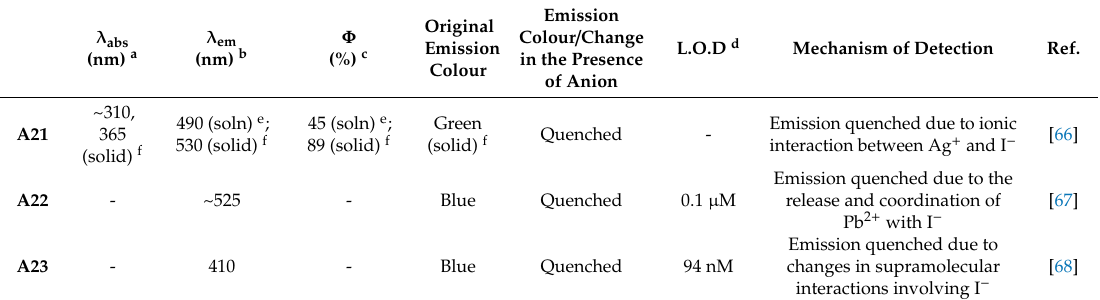
Table 4. Summary of optical properties and sensing performance of AIE-based iodide chemosensors A21 – A23 .